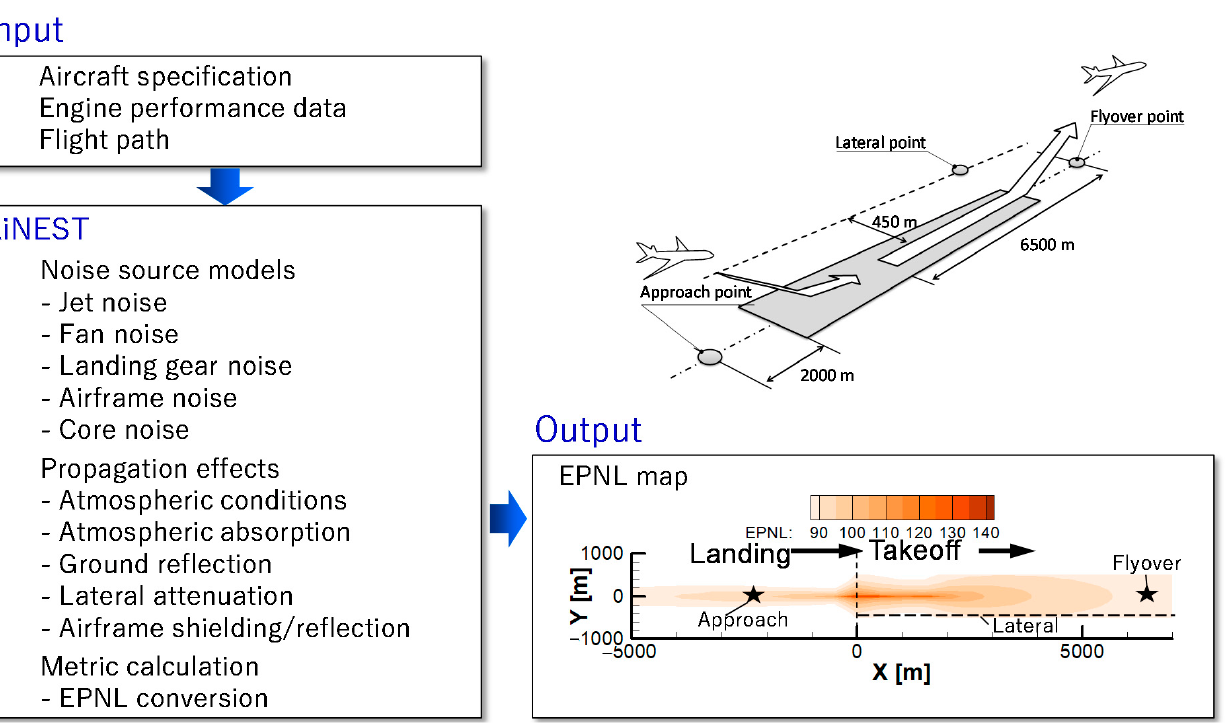
Figure 2. JAXA’s LTO noise prediction tool, AiNEST [14].